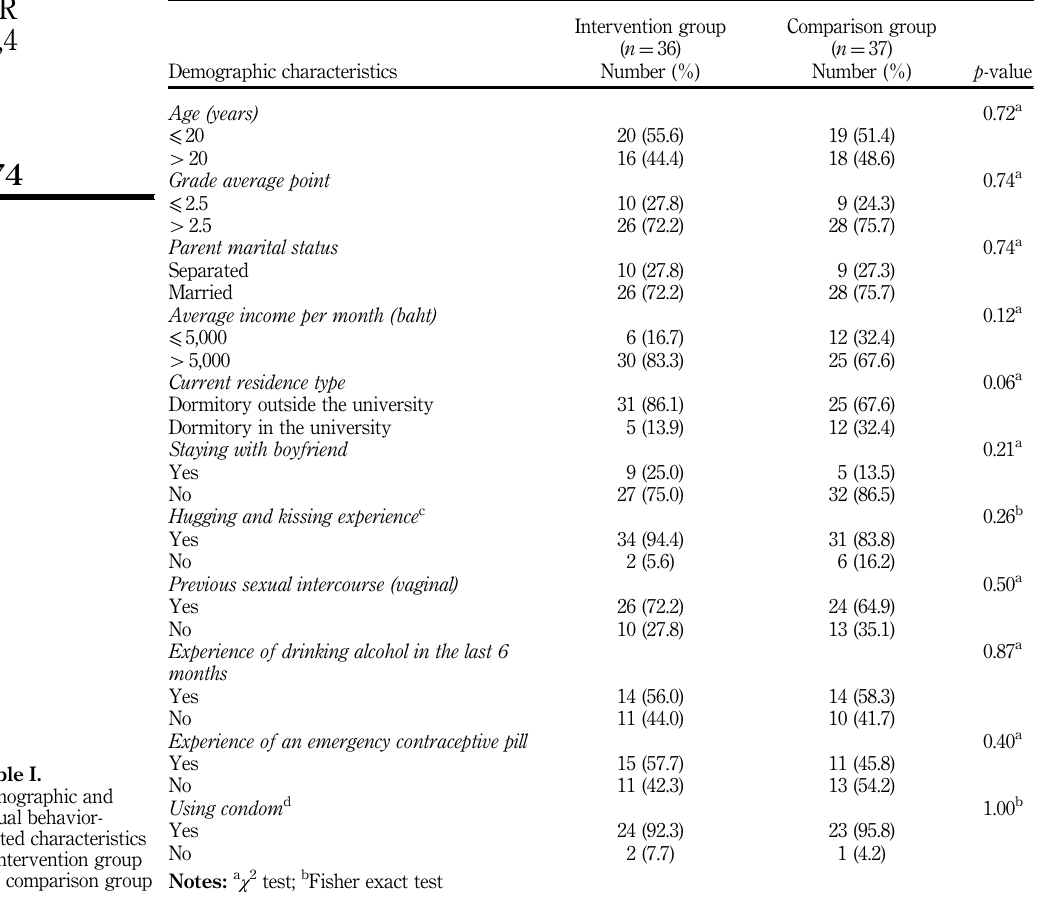
sexual behavior- related characteristics of intervention group and comparison group